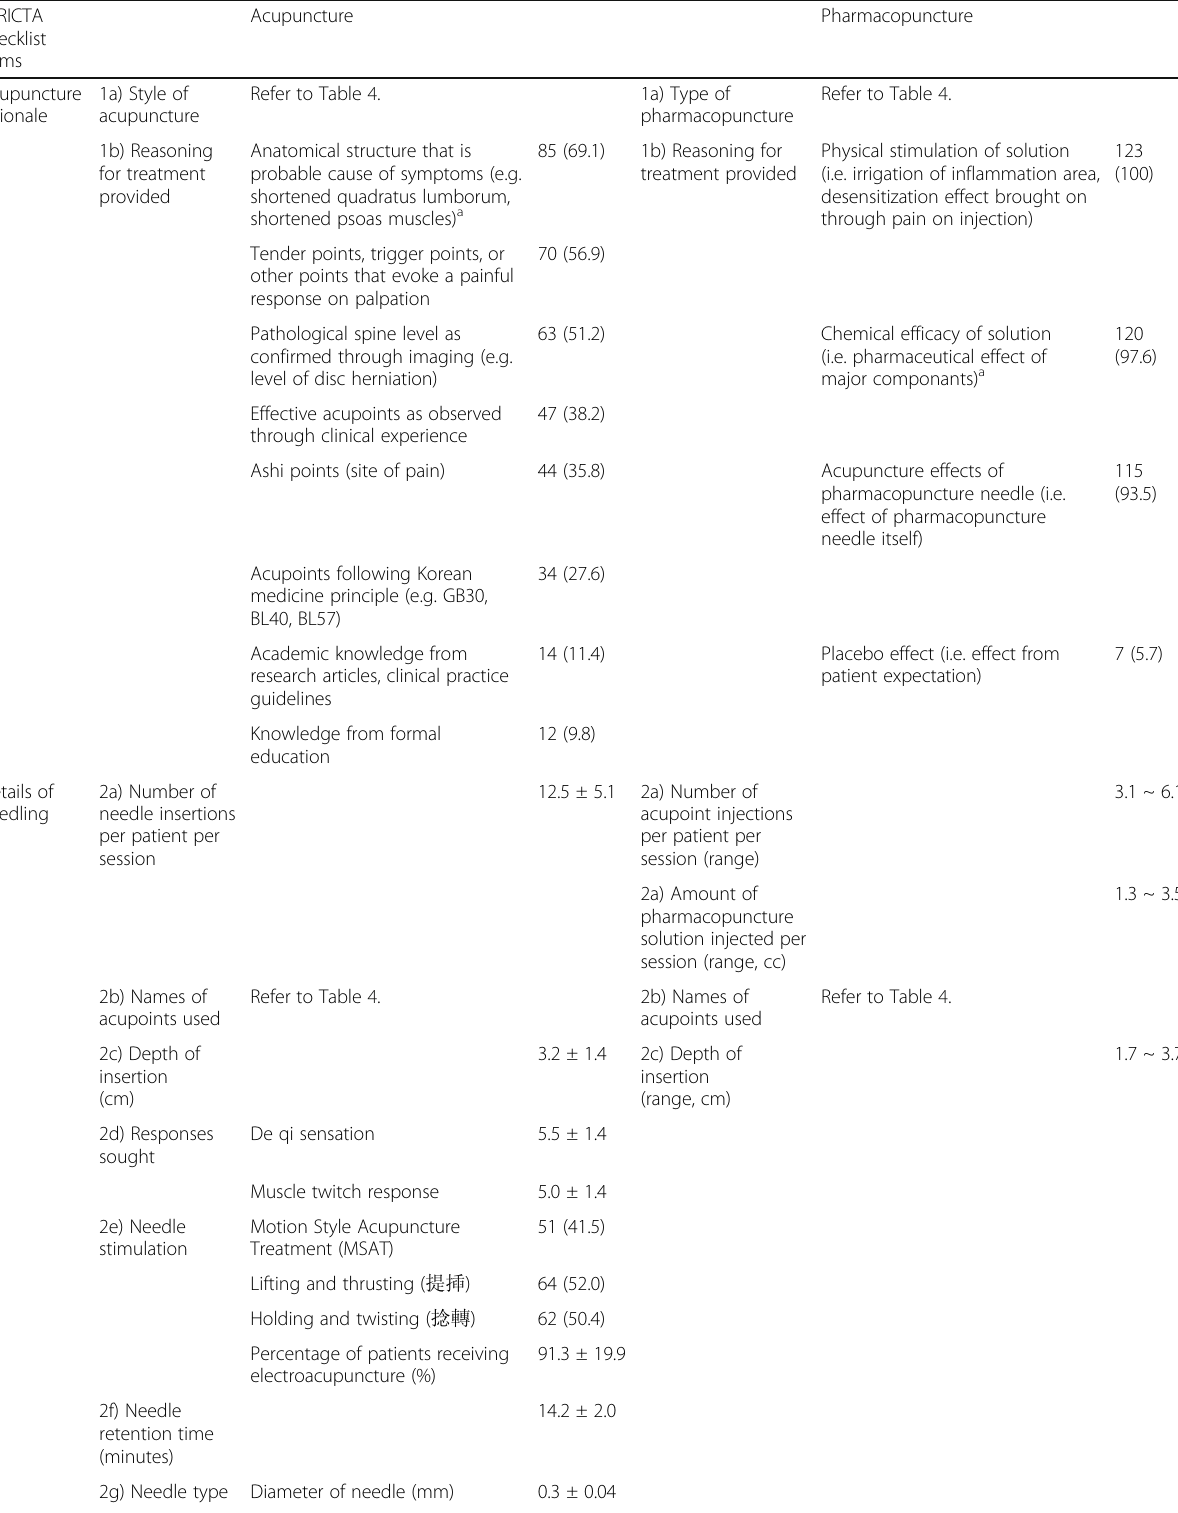
Table 7 Acupuncture and pharmacopuncture treatment used for LSS: data compiled and structured according to STRICTA standards STRICTA